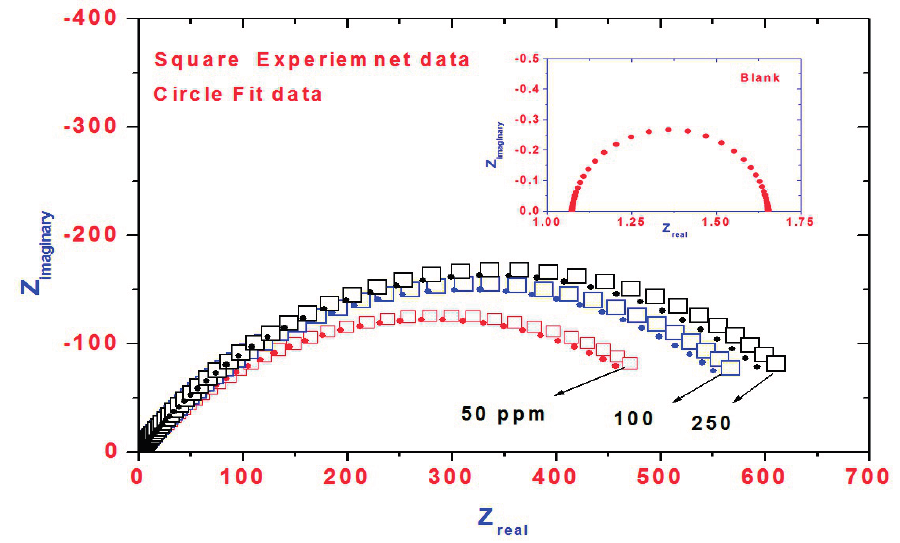
Figure 7. Nyquist diagram for steel in 1 M HCl solution containing different AA-Na/magnetite composites concentrations showing experimental and fit data.